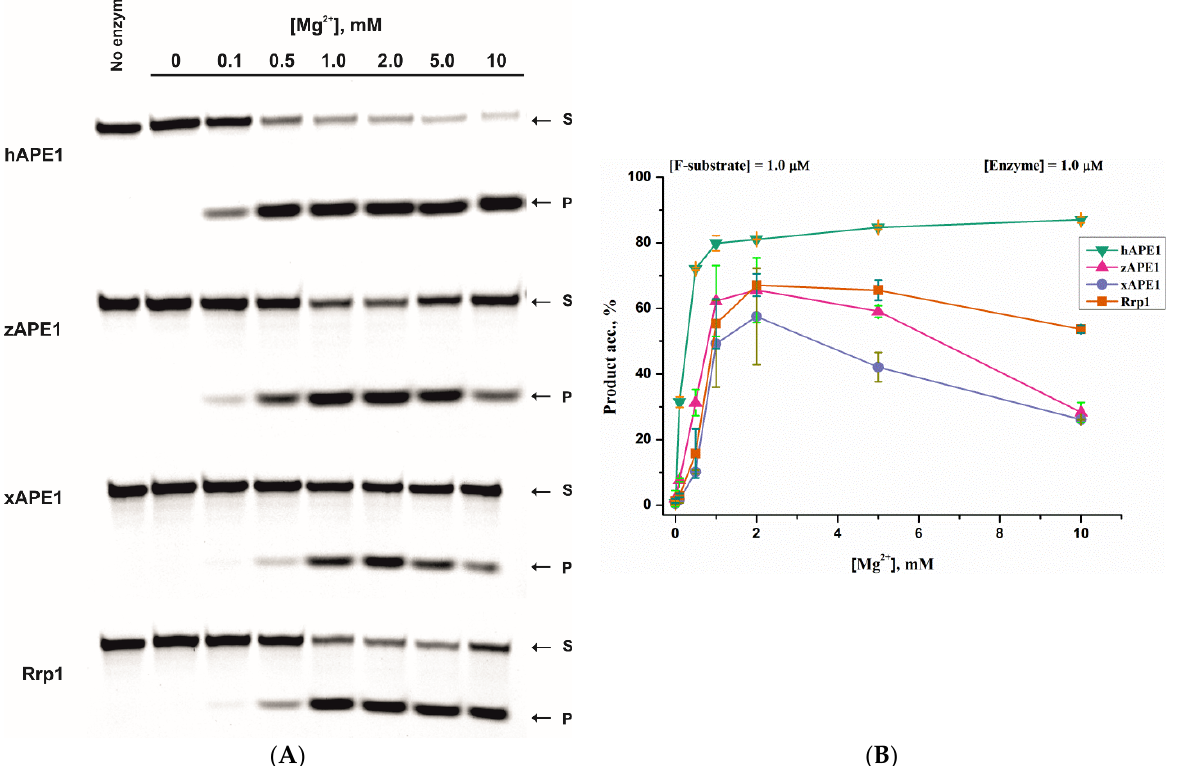
Figure 3. The influence of divalent cations (Mg 2+ ) on the AP-endonuclease activity of the four en- zymes. Accumulation of reaction product P from transformation of F-substrate S as determined by PAGE ( A ). Dependences of the cleavage efficacy on the Mg 2+ concentration ( B ). The error was cal- culated by averaging each data point over at least three replicates.